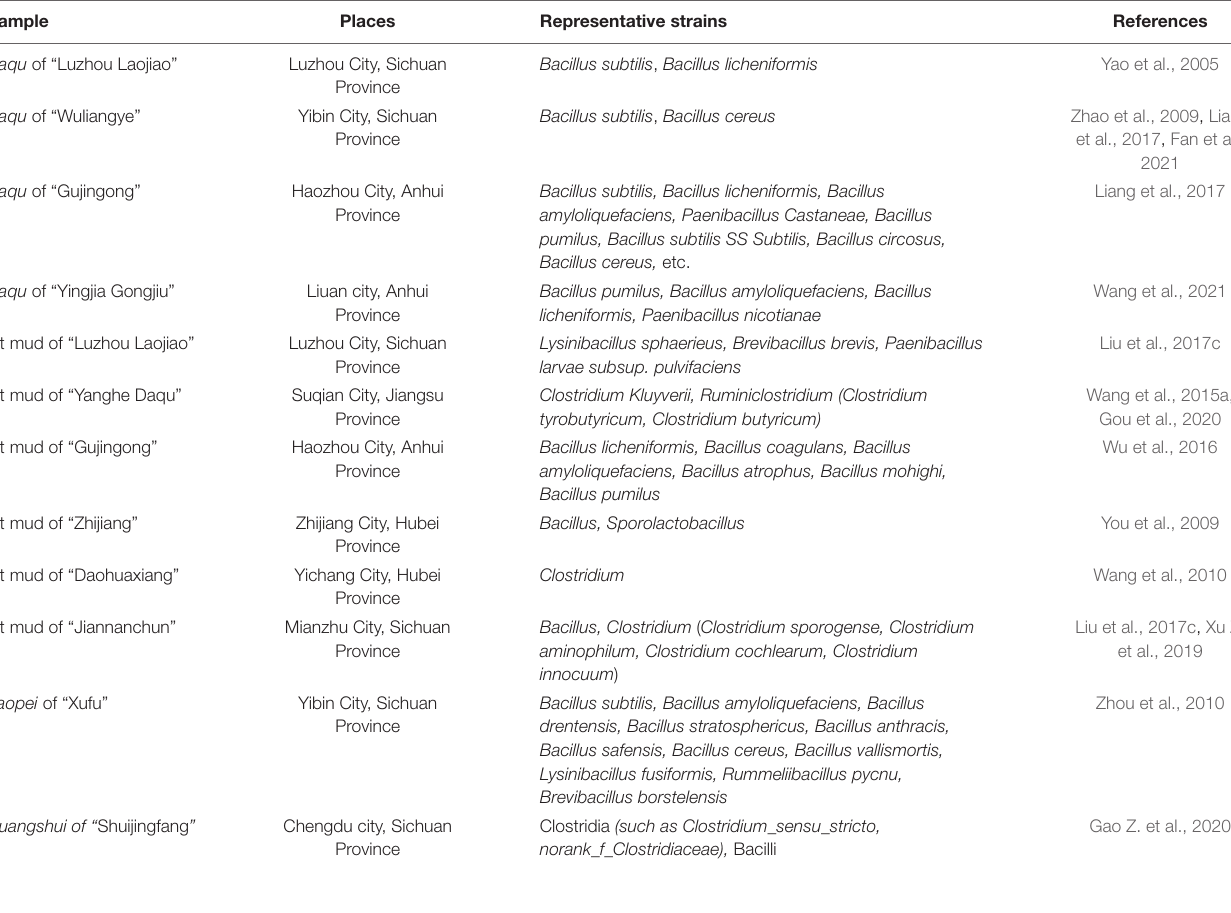
TABLE 1 | Difference distribution of Bacillaceae in SAB distilleries producing Daqu.